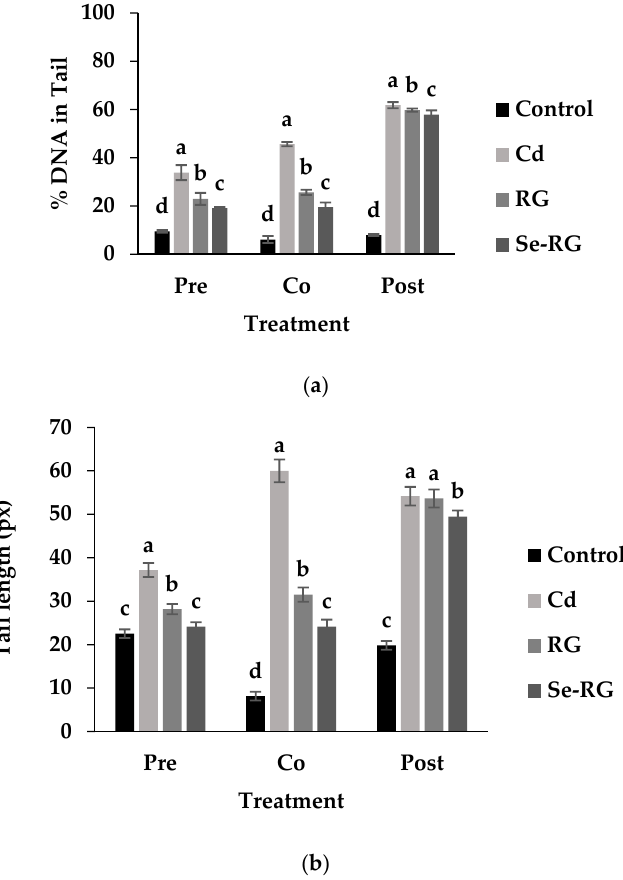
Figure 7. Assessment of DNA damage parameters in HEK293 cells treated with RG and Se-RG at the level 10,000 µg / mL compared to the control and Cd-treated ones evaluated using the CometScore software. ( a ) changes in % DNA in tail; ( b ) changes in tail length. Data are means ± standard deviation (SD). Different letters indicated significant differences ( p < 0.05) in Tukey’s significant differences test.